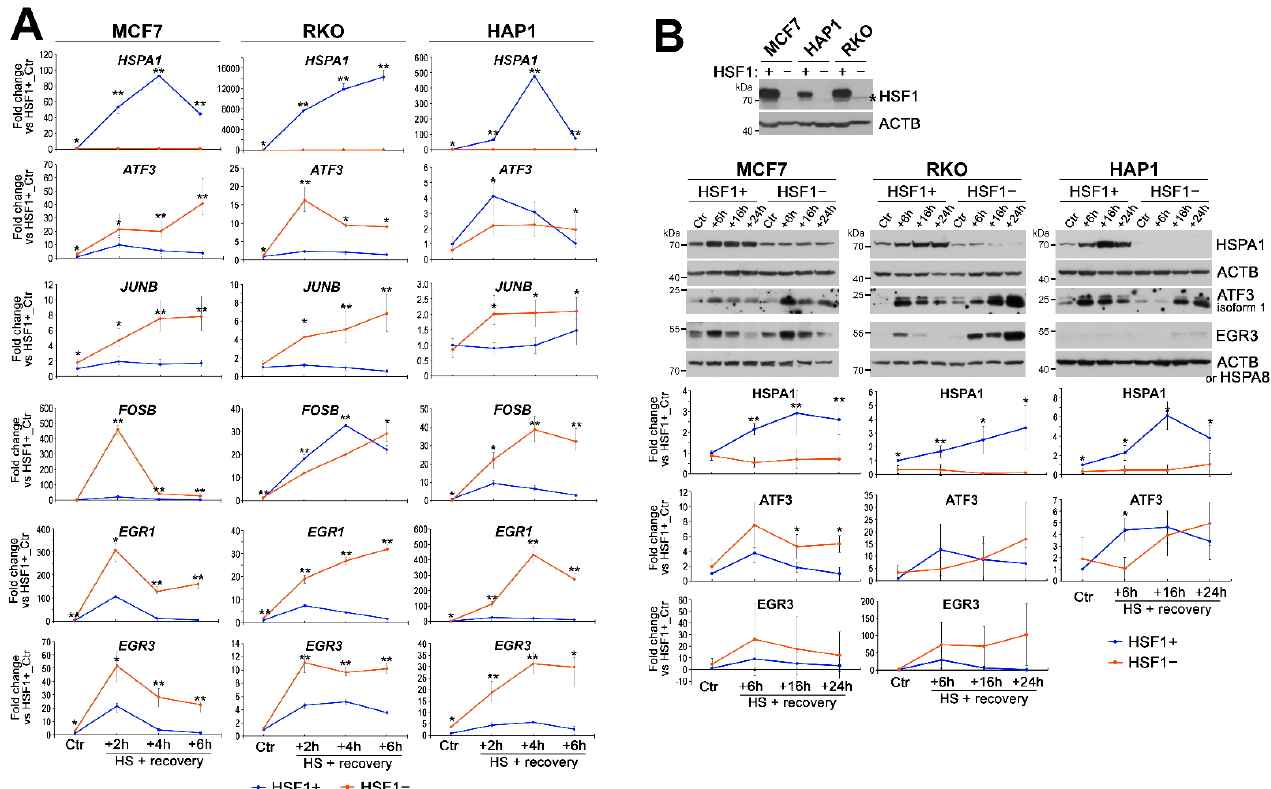
Figure 2. Regulators of cellular stress and growth response are differently expressed in heat-shocked HSF1+ and HSF1 − cells. ( A ) Expression of HSPA1 , ATF3 , JUNB , FOSB , EGR1 , and EGR3 analyzed by RT-qPCR in MCF7, HAP1, and RKO cells exposed to elevated temperature (HS: 43 ◦ C/1 h + recovery 37 ◦ C/2 h, 4 h, or 6 h) in relation (fold change) to untreated control (Ctr) in HSF1+ cells. In the case of MCF7, a different cell model was used than for RNA-seq. Statistically significant differences between HSF1+ and HSF1 − in each time point: ** p < 0.001, * p < 0.05. ( B ) Western blot analyses of HSF1 (the asterisk shows non-specific bands) in untreated HSF1+ and HSF1 − MCF7, HAP1, and RKO cells and HSPA1, ATF3, and EGR3 up to 24 h of recovery from one-hour heat shock. ACTB or HSPA8 were used as loading controls. Results of densitometric analyses (n = 2–4) are shown below blots (note that highly variable EGR3 expression resulted in large standard deviations). Statistically significant differences between HSF1+ and HSF1 − in each time point: ** p < 0.001, * p <